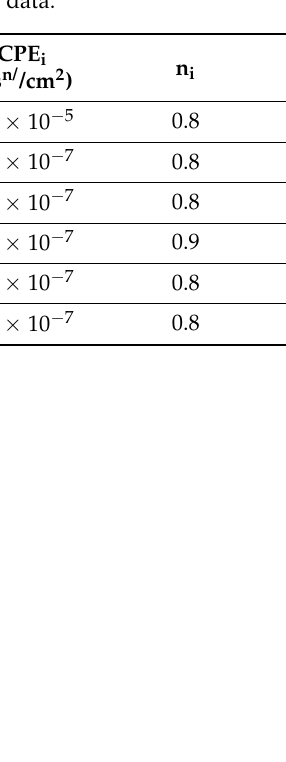
Figure 9. EIS data in ( a ) Nyquist and ( b ) Bode diagrams for Ti6Al4V alloy oxidized during 8 h and corroded in artificial saliva solution after different exposure times. Table 2. Electrochemical parameters used to fit EIS data.